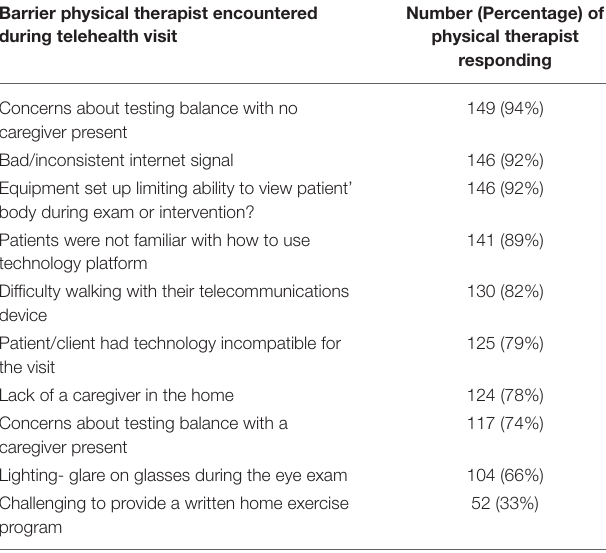
TABLE 2 | (A,B) Percentage of physical therapist respondents who reported that they could effectively provide vestibular examination techniques and specific exercises via telehealth ( n = 159).